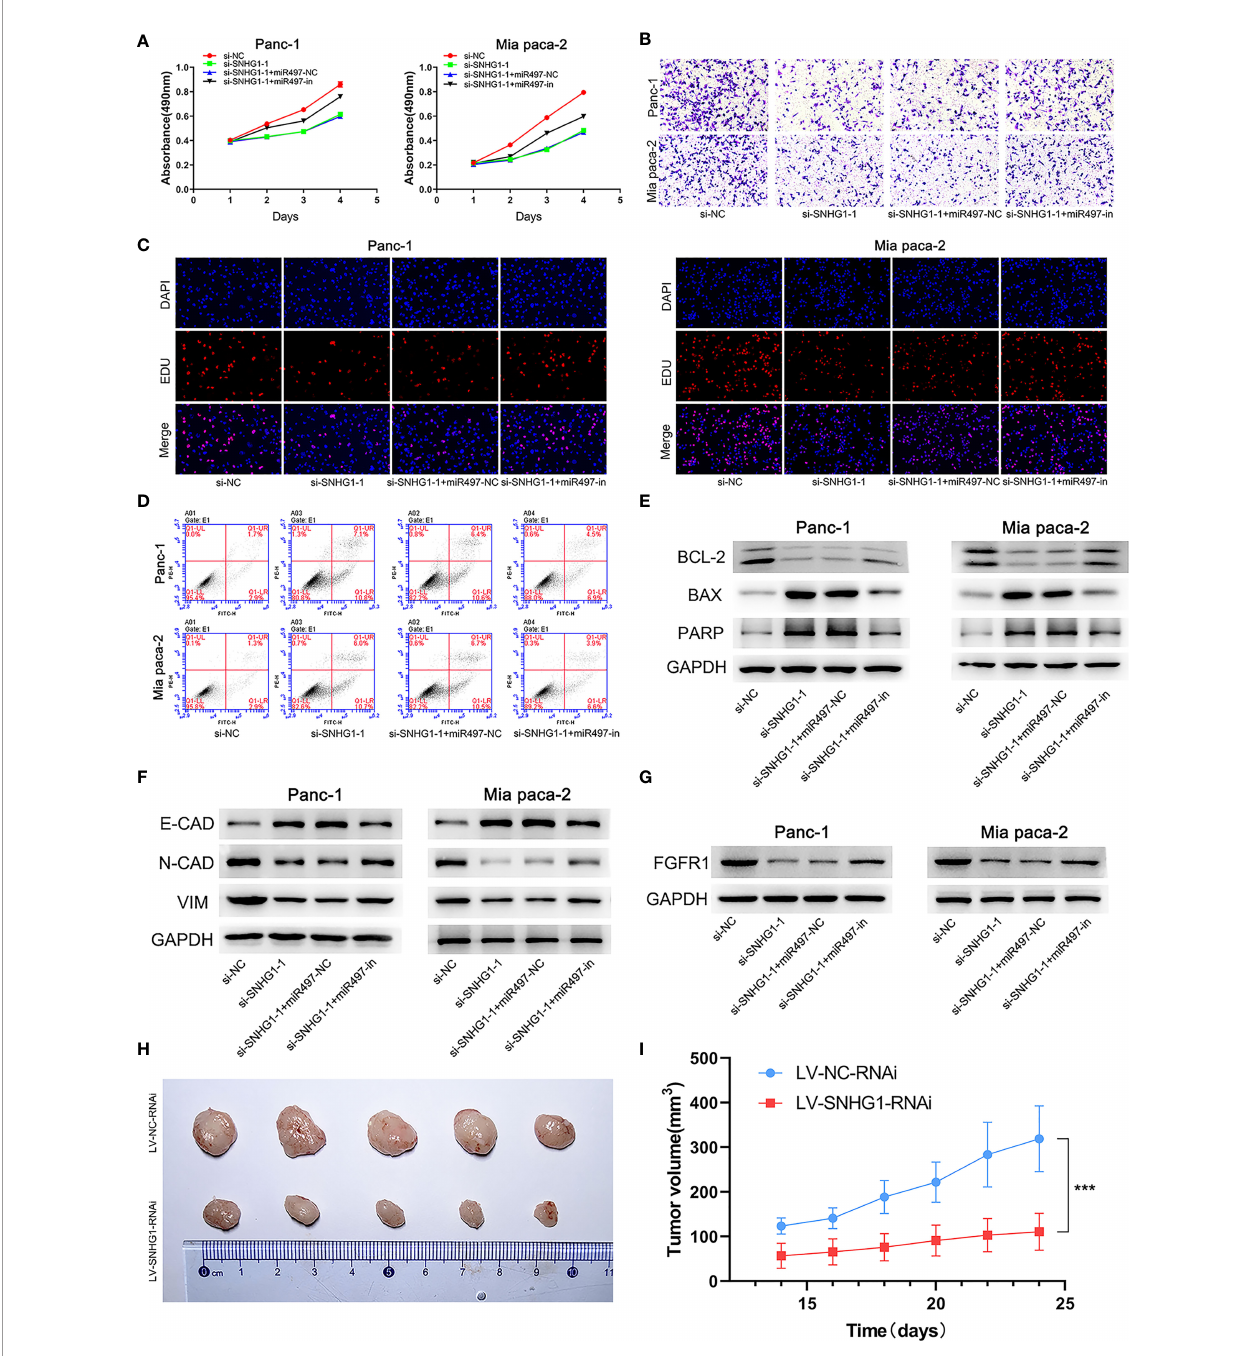
FIGURE 9 | SNHG1 regulates PC cell proliferation, viability, invasion, and apoptosis via the miR-497/FGFR1 signaling pathway. (A) Cell viability was measured by MTT. (B) Cell invasion was measured by Transwell assay. (C) Proliferation was measured by the EDU assay. (D) Apoptosis was shown by fl ow cytometry. (E, F) WB showed expression of apoptosis-related and EMT-related proteins. (G) WB quanti fi cation of FGFR1 expression. (H, I) The in fl uence of SNHG1 on tumor growth in nude mice. ***p <